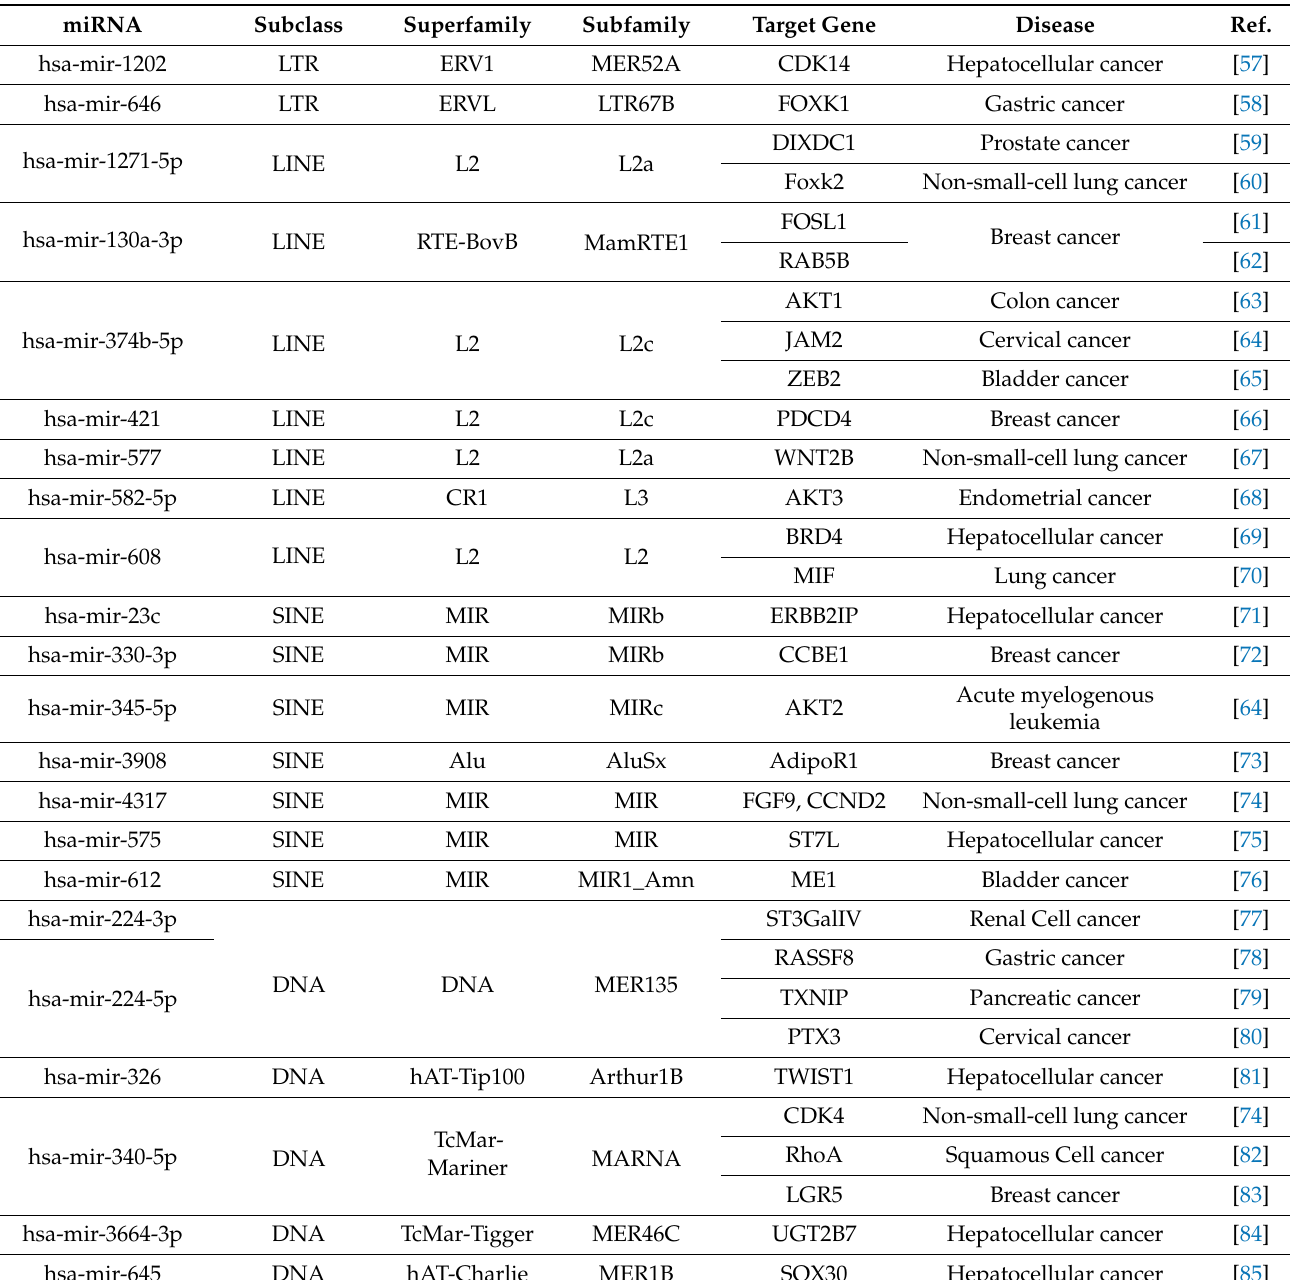
Table 2. MDTEs in relation to human